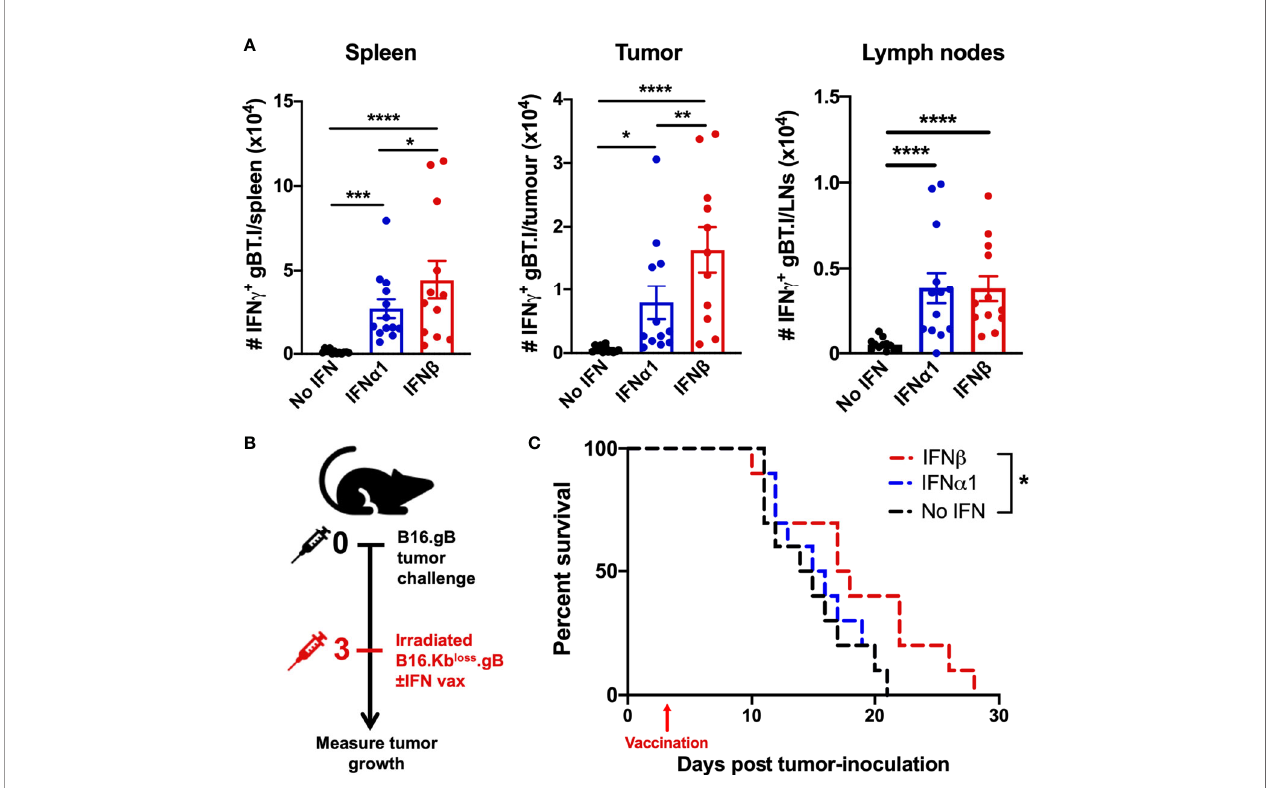
FIGURE 3 | Increased tumor-reactive CD8 + T cell in fi ltration into the tumor and prolonged survival in mice vaccinated with IFN b -secreting B16 cell lines. (A) B16.gB tumor-bearing mice received 5 x 10 4 naïve gBT.I cells one day prior to vaccination with 2.5 x 10 6 irradiated B16.Kb loss .gB ± IFN cells. Seven days post- vaccination, expansion of IFN g -producing gBT.I, in response to restimulation with gB peptide was enumerated in the spleen, tumor, and ipsilateral lymph nodes (axillary, brachial and inguinal) (n = 12 per group). (B, C) Experiment schematic (B) and survival curves (C) of mice receiving vaccination with 2.5 x 10 6 irradiated B16.Kb loss .gB ± IFN cells (n = 10 per group). Data is pooled from 2-3 biologically independent repeats and analysed by one-way ANOVA for (A) and Log-rank Mantel-Cox test for (C) , ****p < 0.001, ***p < 0.005, **p < 0.01, *p < 0.05. Bars represent mean ±